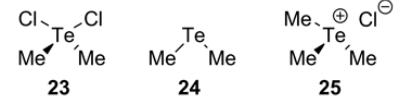
Fig. 11 – Tellurium-based inhibitors of cholesterol